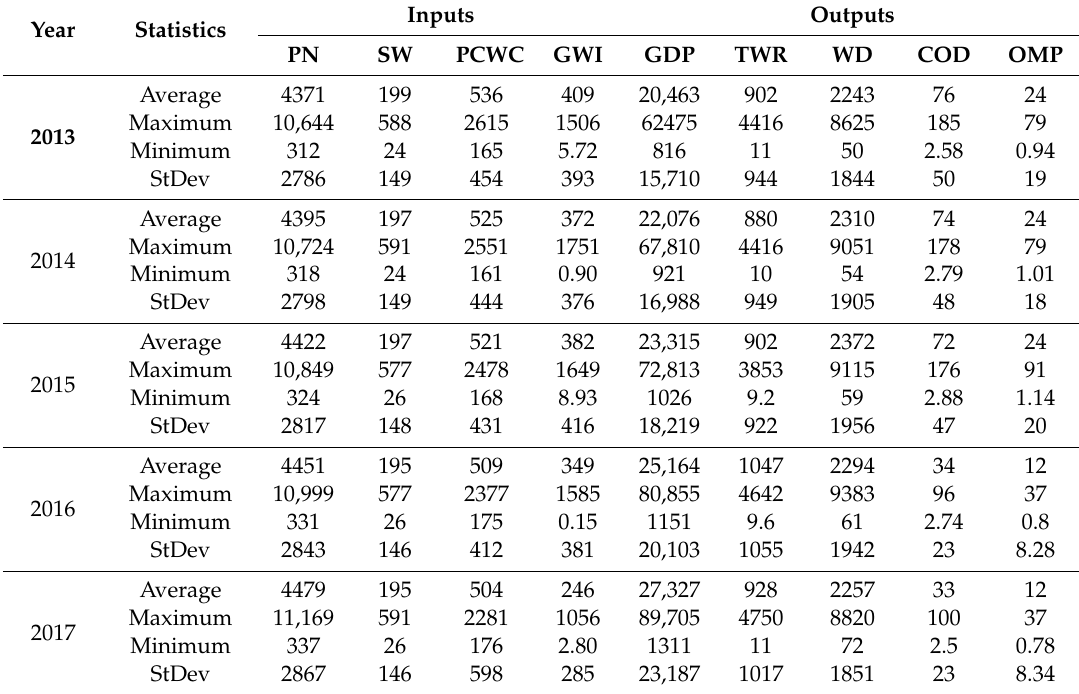
Table 2. Descriptive statistics of input and output data in